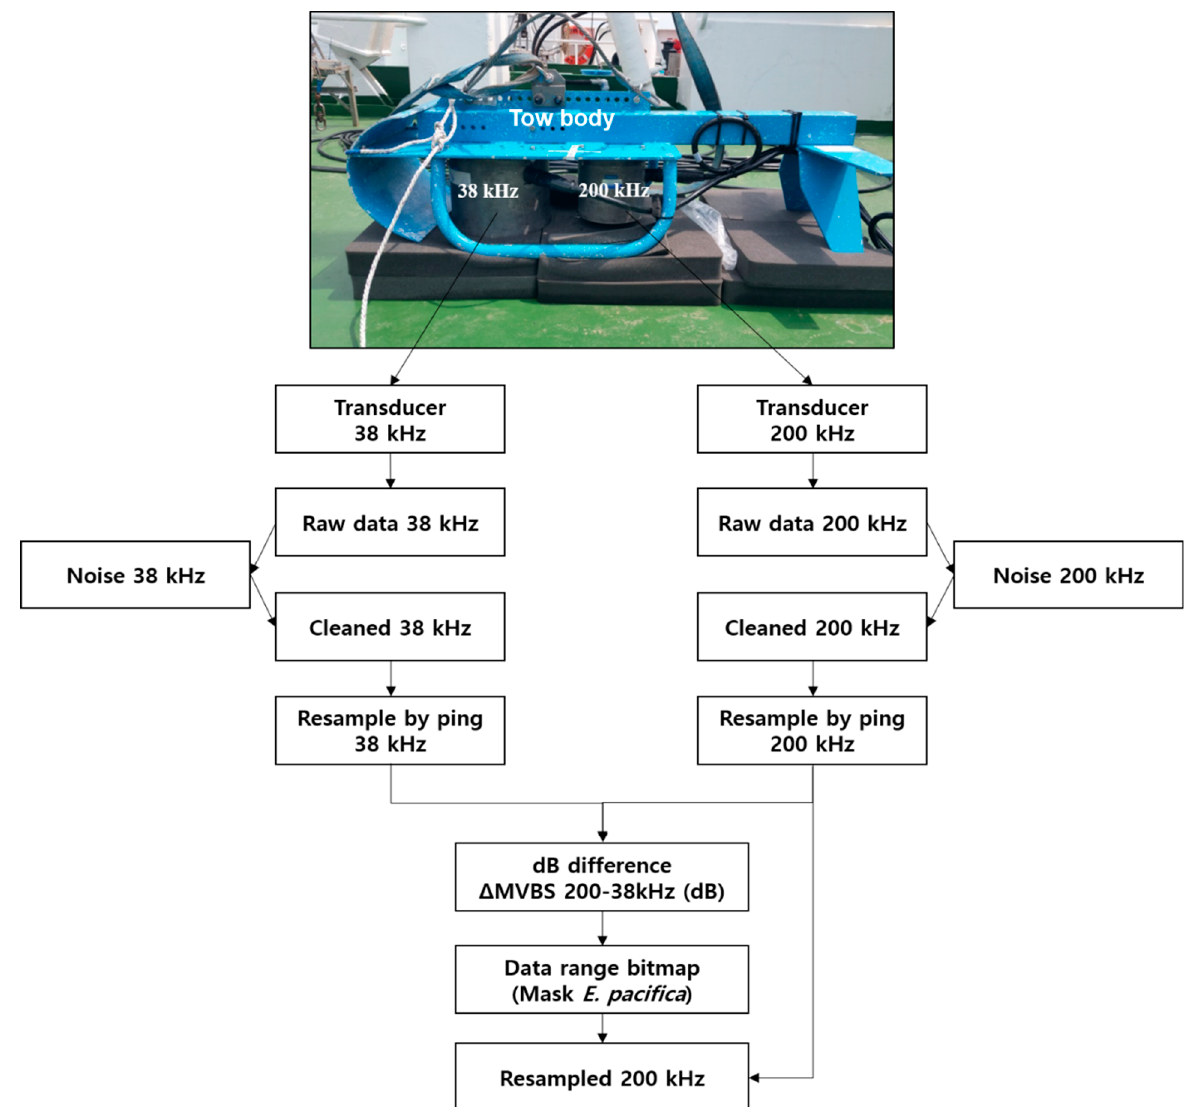
Figure 2. Flowchart of acoustic data processing using the dB difference method at 38 and 200 kHz .